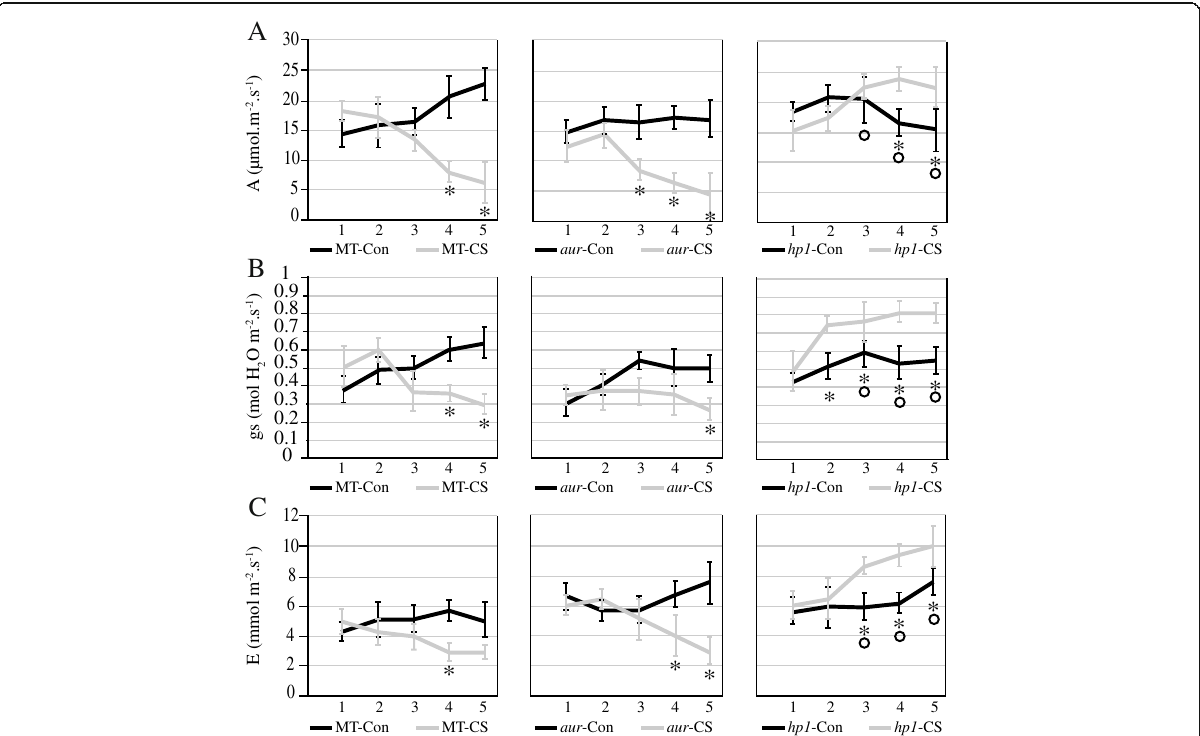
Fig. 1 Effects of chilling stress on gas exchange parameters. a Photosynthetic rate denoted as A and measured in μ mol m − 2 s − 1 , b stomatal conductance denoted as gs and calculated in mol H 2 O m − 2 s − 1 , and c transpiration rate denoted as E and calculated in mmol m − 2 s − 1 . Samples were obtained from leaves of wild-type genotype (MT) and aurea ( aur ) and high pigment1 ( hp1 ) mutants of tomato cv. Micro-Tom. Blue lines indicate the effects on plants under control (Con) conditions whereas green lines show effects after chilling stress (CS). The data were collected and compared for each day until 5 days under chilling stress. Symbols that are not similar show significant differences (calculated by Tukey ’ s test, P < 0.05). Comparisons between the control and stress treatments within the same genotype were indicated as asterisks, whereas circles were used for comparisons among genotypes under the stress treatment